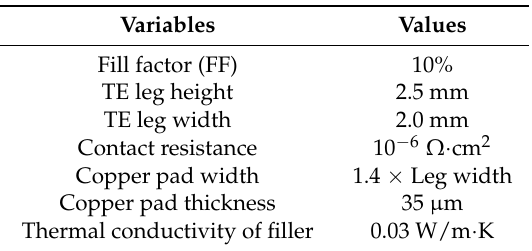
Table 1. Variables related to the device structure. All variables were applied to values that could be used in a human body application.